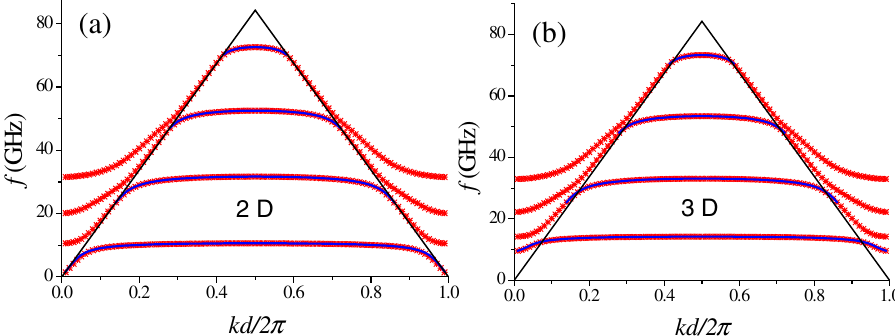
FIG. 14. Comparison of our theory with that of McVey et al. , Ref. [23], for the grating discussed therein. (a) Blue curves, 2D Andrews and Brau dispersion relation. Red dotted curves, our extension of that to a roofed grating. (b) Blue curves, our 3D dispersion relation. Red dotted curves, the extension of our theory to a roofed grating. The latter agree with results shown in Ref.